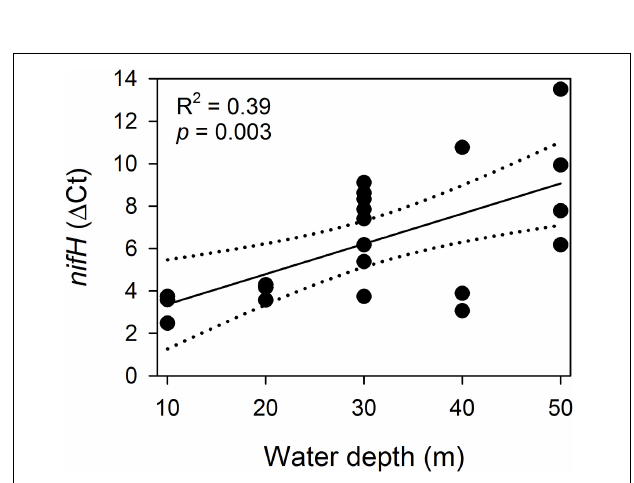
FIGURE 4 | Linear regression analysis for (cid:49) Ct of nifH (relative to the corresponding 16S rRNA Ct value) and water depth. Dotted lines represent 95% confidence intervals. Note that lower (cid:49) Ct values correspond with higher relative nifH gene copy